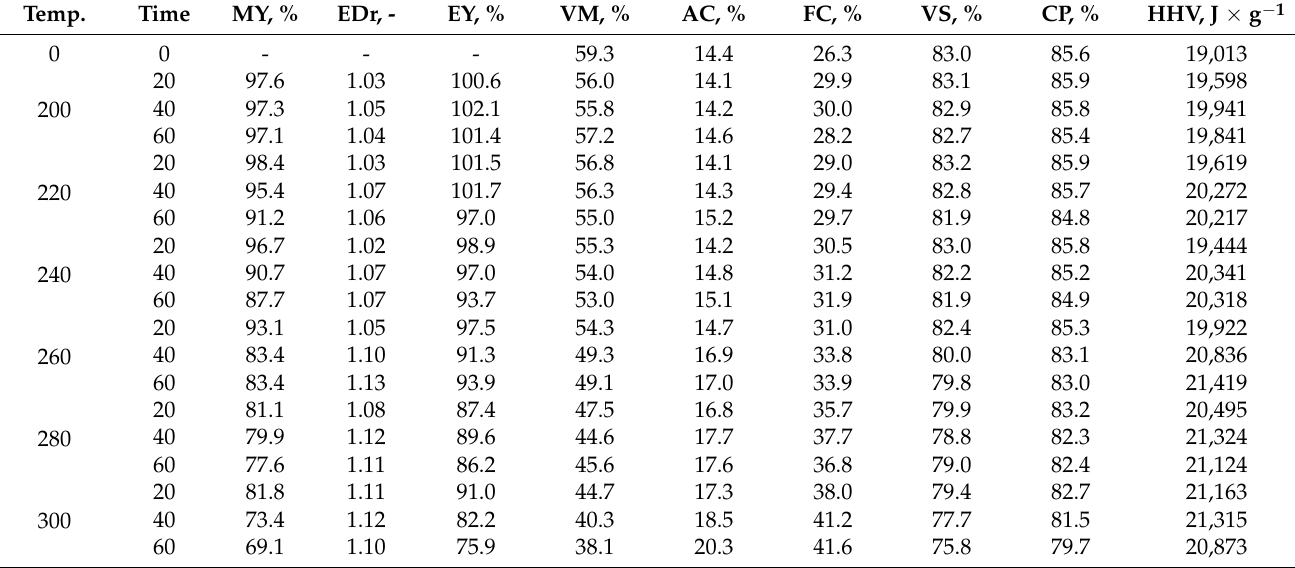
Table 1. Results of CSF production and CSF